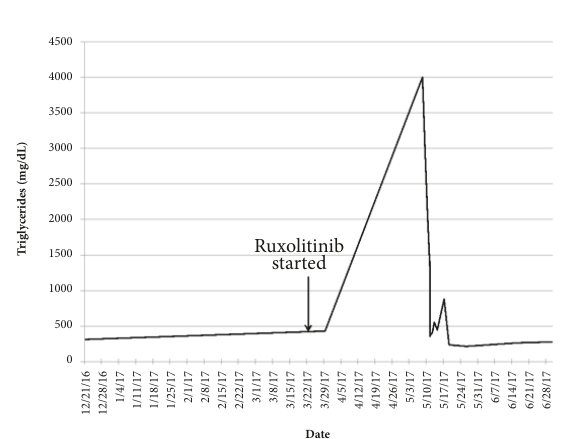
Figure 1: Serum triglyceride level with relation to starting ruxoli- tinib for chronic